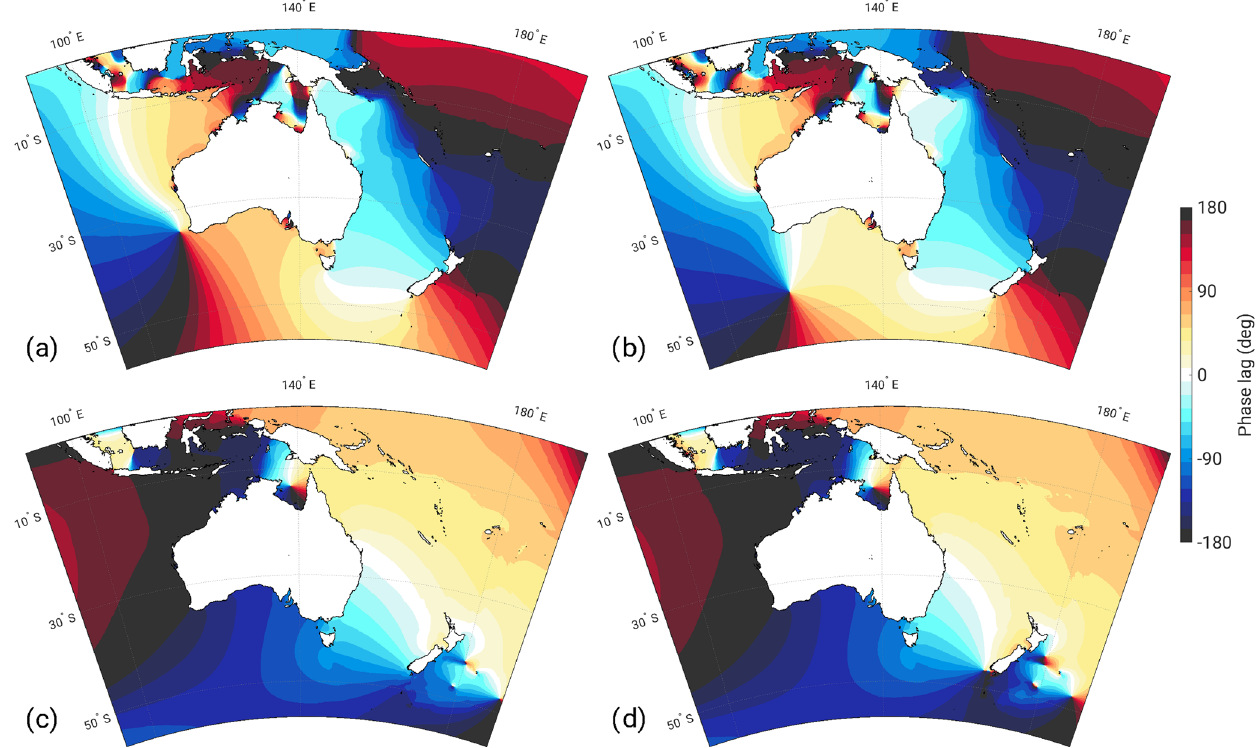
Figure 4. The constituent phase lags with respect to the Greenwich meridian ( ◦ ) for the control (a, c) and 7m SLR (b, d) simulations for M 2 (a, b) and K 1 (c, d)